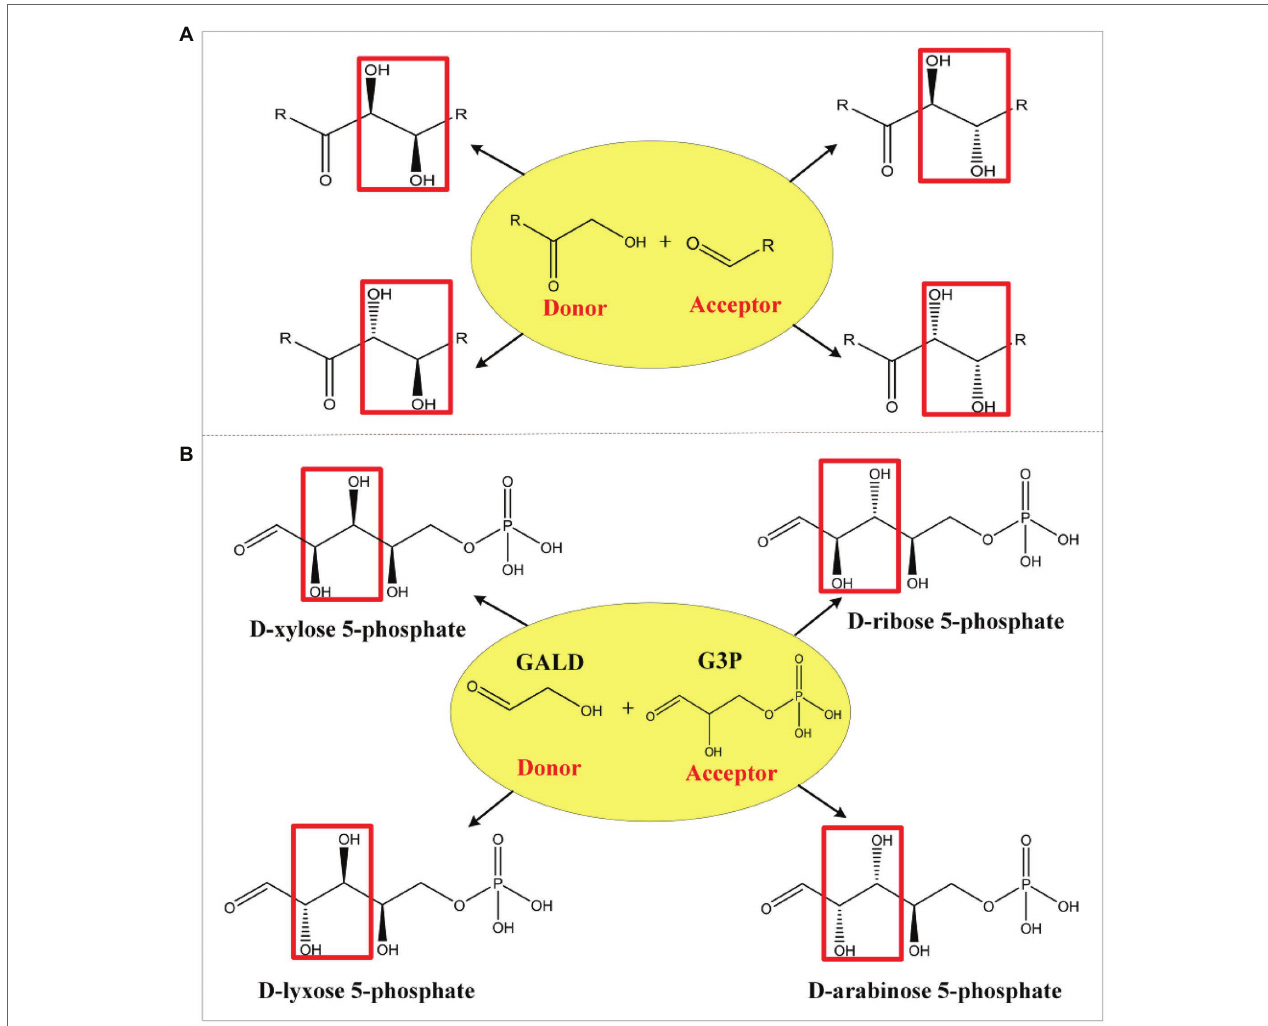
FIGURE 2 | Schematic diagram of aldol reaction mechanism. Complementary stereochemistry of aldolases (A) and the four stereo configurations (B) when GALD serves as donor and G3P serves as